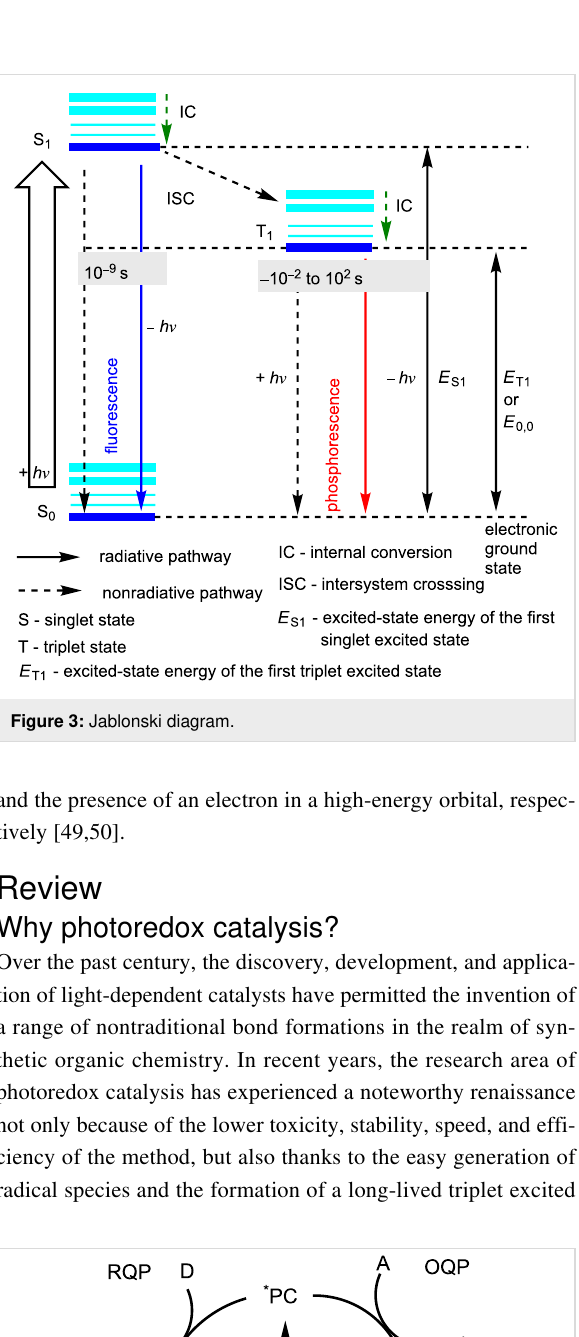
and the presence of an electron in a high-energy orbital, respec- tively